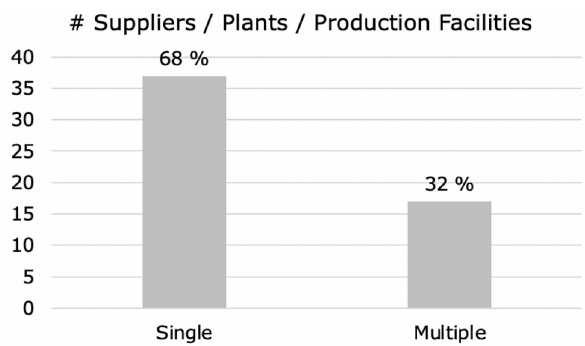
Figure 6. Statistics on supply chain structure: # suppliers/plants/production facilities